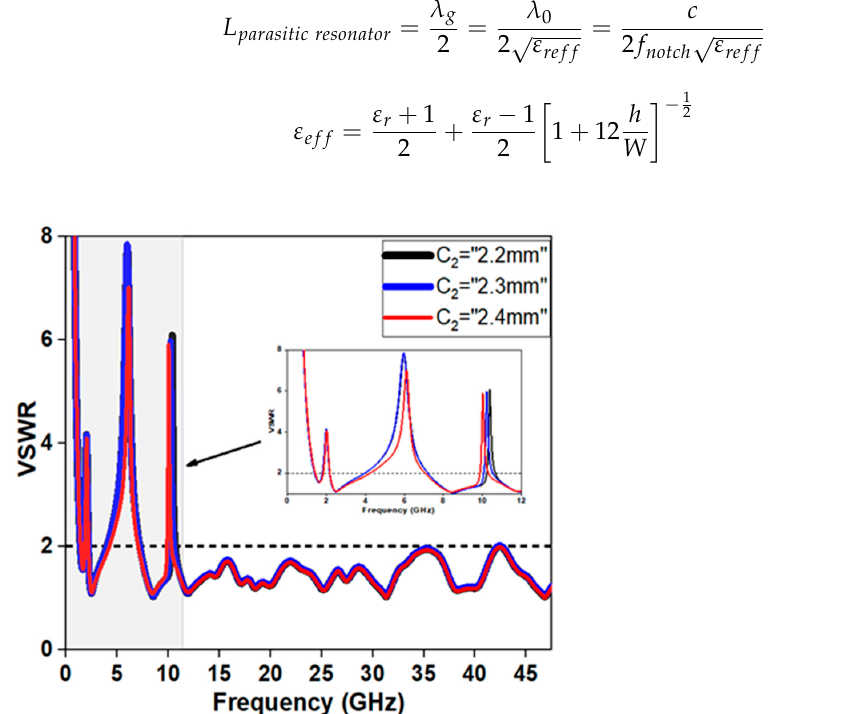
Figure 8. Parametric variation of the independently controllable C band notch by varying C 2.